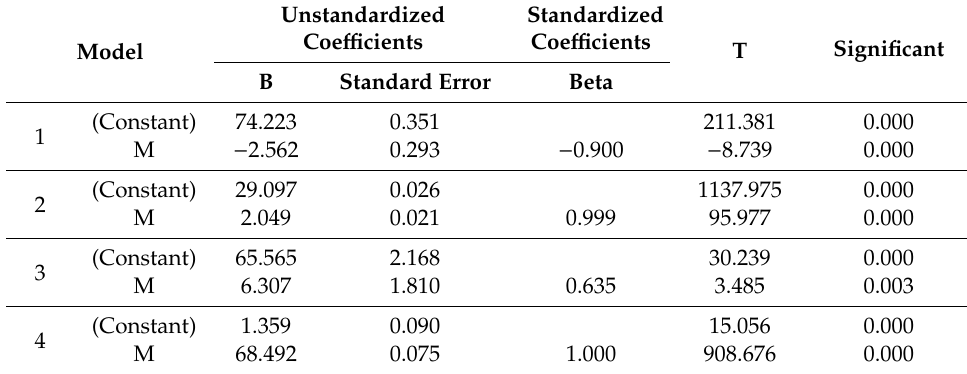
Table 2. Coe ffi